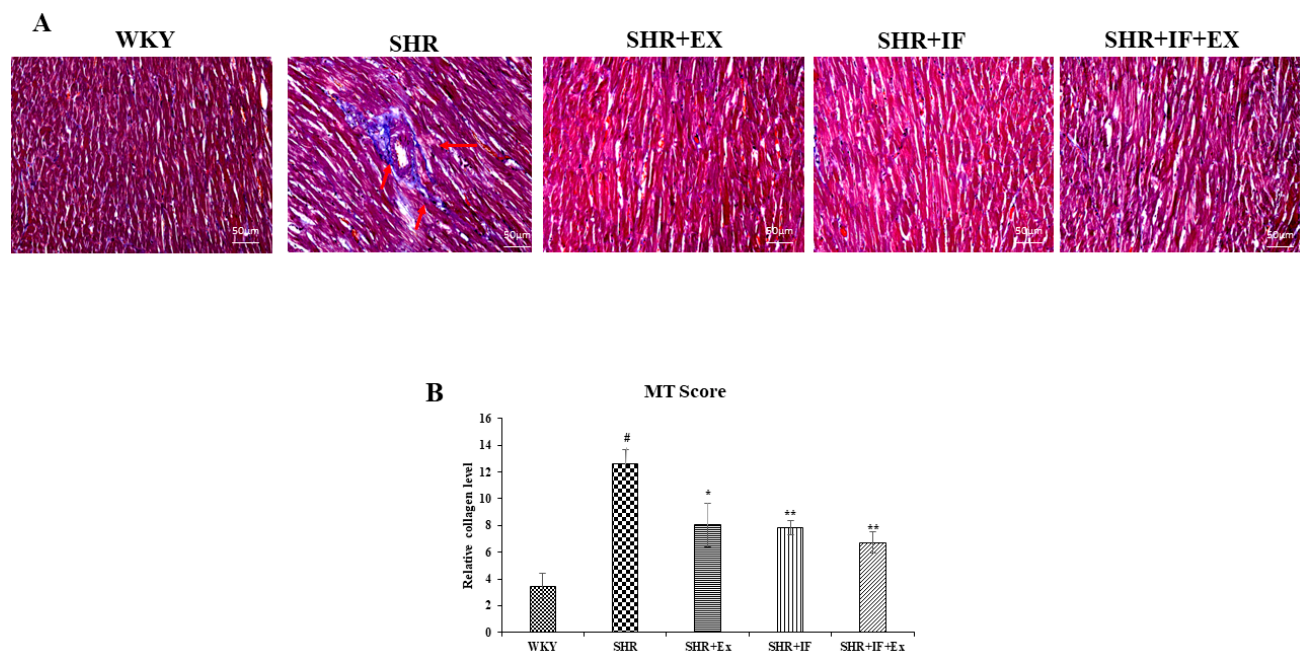
Figure 4. IF treatment and exercise prevent fibrosis in SHR rats. ( A ) Masson’s trichrome staining; Red arrow showing collagen accumulation ( B ) semi-quantitative analysis of fibrosis. MT Score, Masson’s trichrome score. n = 8, # p < 0.01 compared to WKY, * p < 0.05, and ** p < 0.01 compared to SHR.